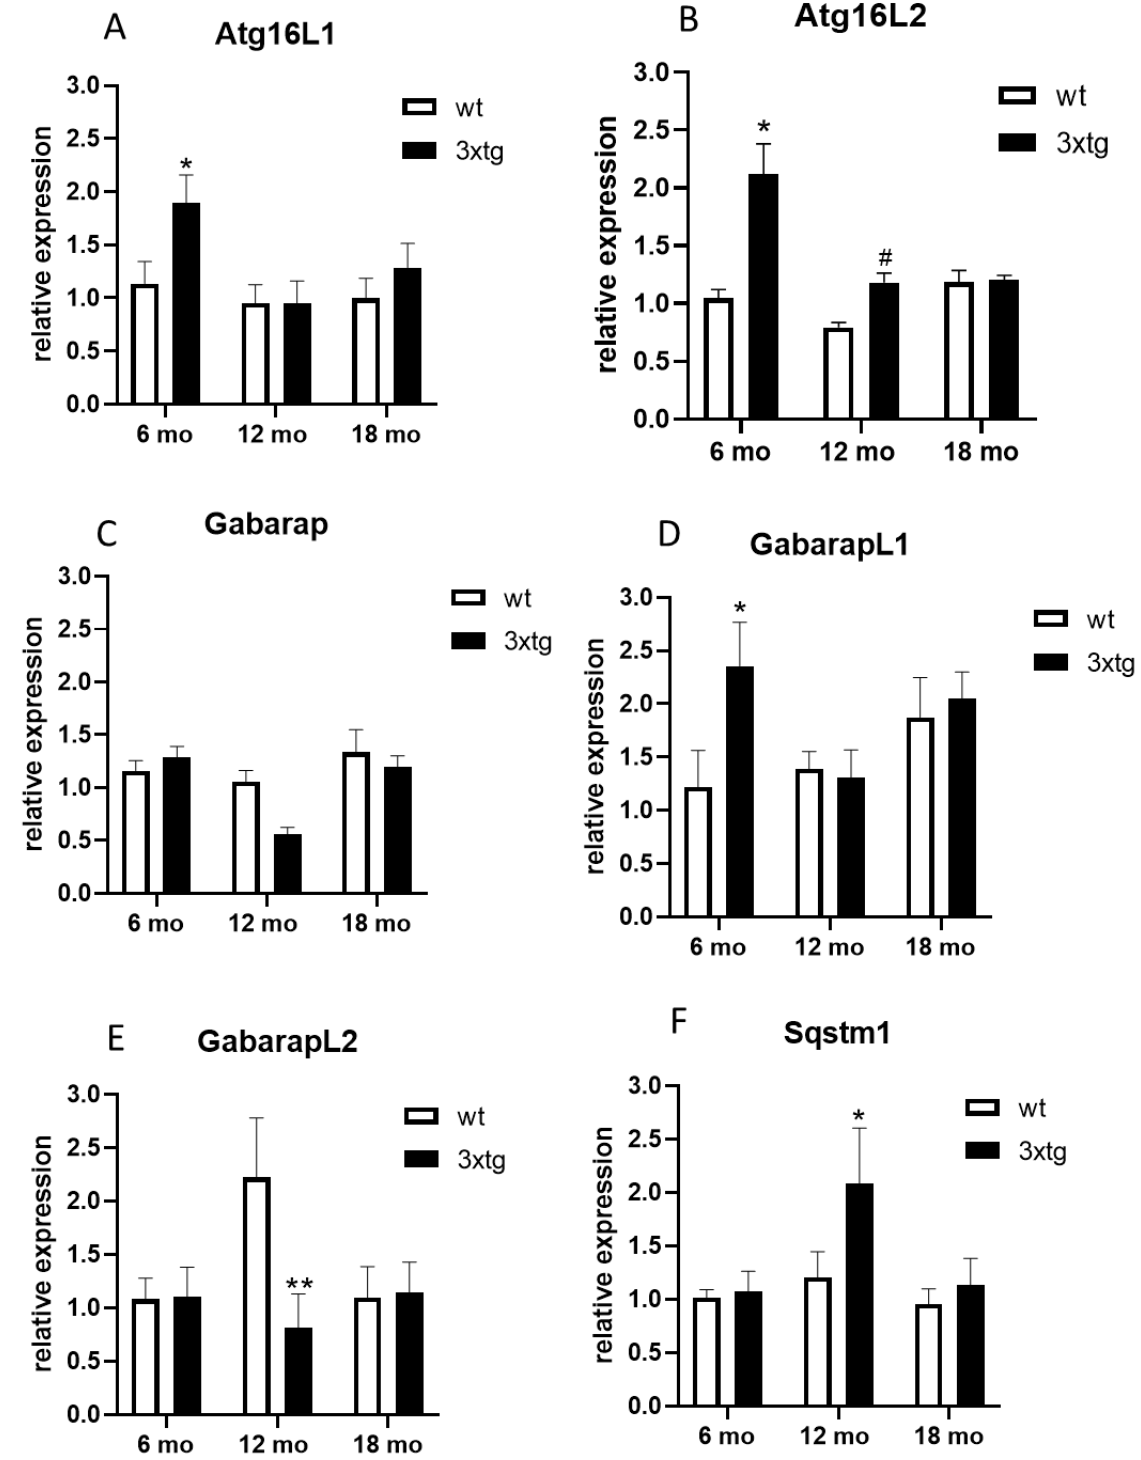
Figure 1. Hippocampal mRNA levels of Atg16L1 ( A ), Atg16L2 ( B ), Gabarap ( C ), GabarapL1 ( D ), GabarapL2 ( E ), and Sqstm1 ( F ) in 3xTg-AD (3xTg) or wild-type (wt) mice at 6, 12, and 18 months (mo) of age. The means + SEM are plotted. **: p < 0.01; *: p < 0.05; #: 0.05 < p < 0.09 in the planned comparison vs. wt; n = 6/group.